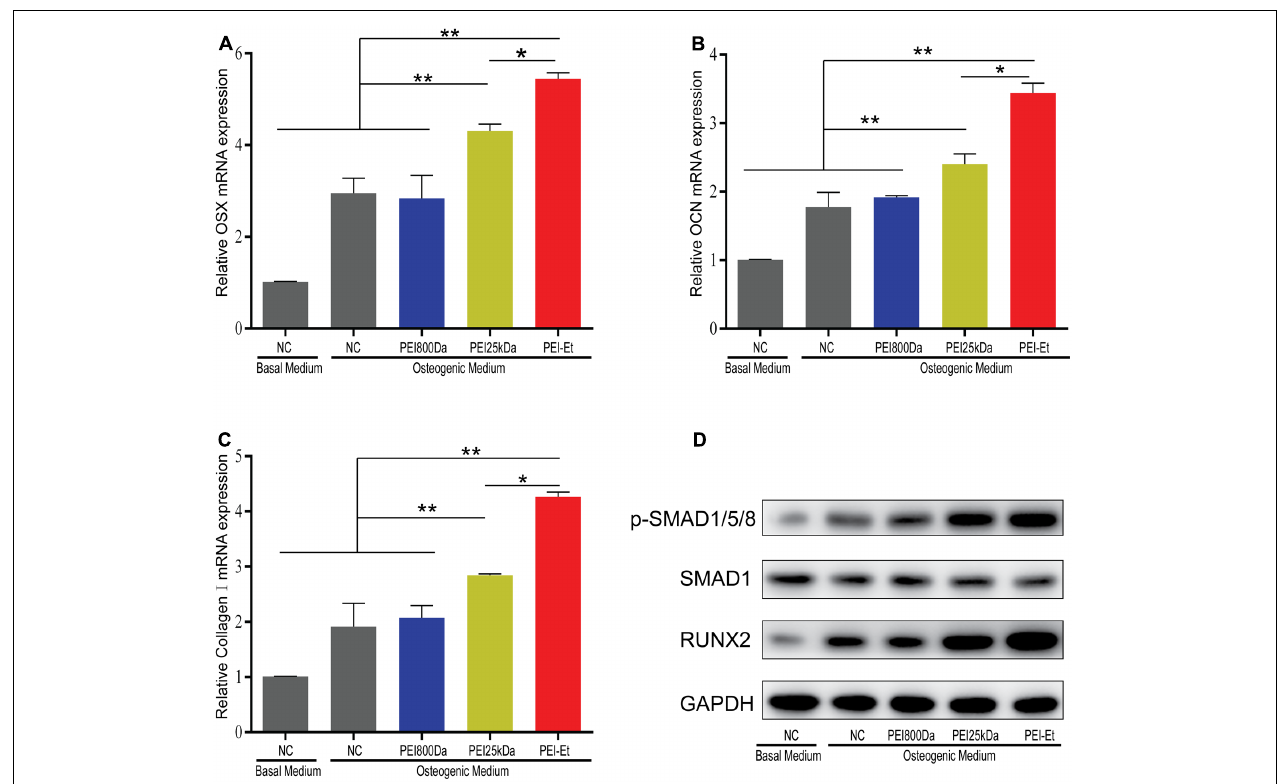
FIGURE 5 | Osteogenesis gene expression of hBMSCs transfected with PEI-Et/Chordin-siRNA polyplexes. The mRNA expression levels of OSX (A) , OCN (B) , and Col1a1 (C) were measured by real-time PCR at 7 days after transfection with different polyplexes. (D) The expression levels of RUNX2 and p-SMAD1/5/8 complexes were measured by Western blot analysis. RUNX2 and p-SMAD1/5/8 protein levels were normalized to GAPDH and SMAD1, respectively. Representative images of three independent experiments were shown. Data are presented as the means ± SD of three independent experiments. ∗ P < 0.05, ∗∗ P <